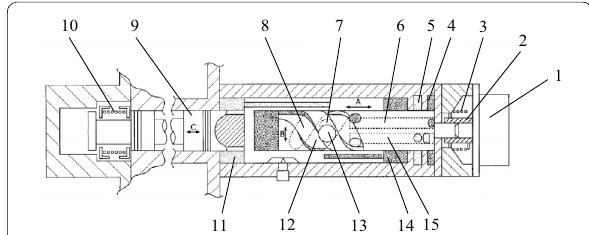
Figure 12 Pilot rotary-spool driven electro-hydraulic directional control valve. 1. Rotary motor; 2. Coupling; 3. Torsional spring; 4. Oil supply port; 5. Oil return port; 6. High pressure oil circuit; 7. Back valve sleeve window; 8. Low pressure spiral groove; 9. Main spool; 10. Compression spring; 11. Left sensitive chamber; 12. High pressure spiral groove; 13. Front valve sleeve window; 14. Right